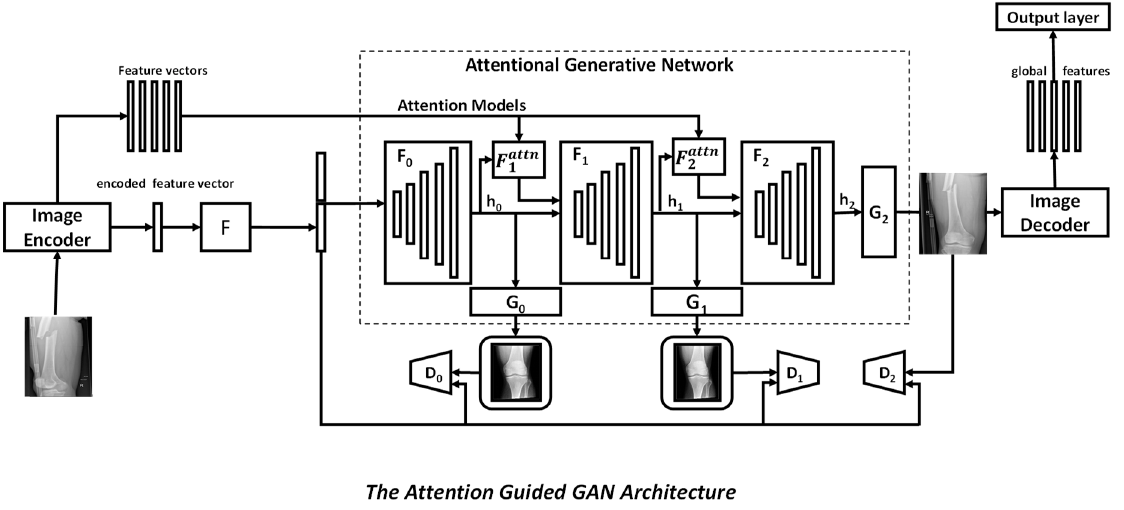
Figure 4. General architecture of attention guided